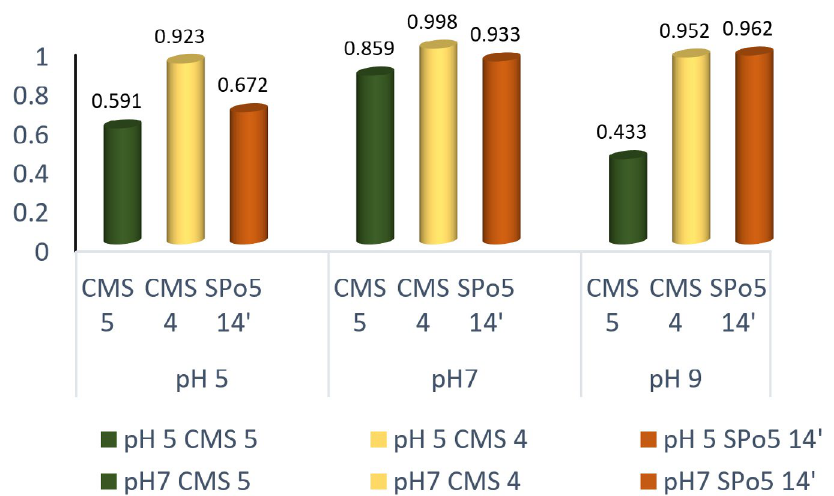
Fig. 6. Effect of pH on growth in three Bacillus strains: Bacillus subtilis (CMS5), Bacillus sp. (CMS4) and Bacillus velenzensis (SPo5 14')